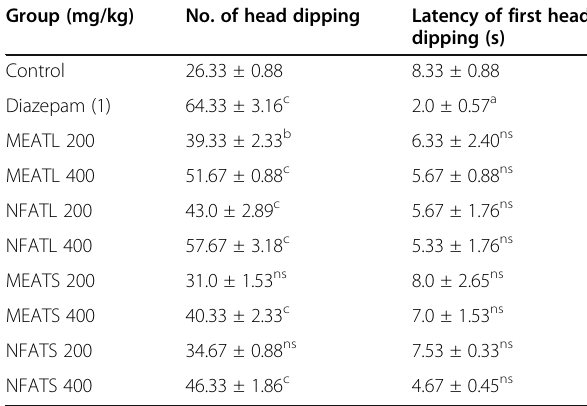
Table 2 Anxiolytic activity of different extract of A. trilobata on hole-board test in